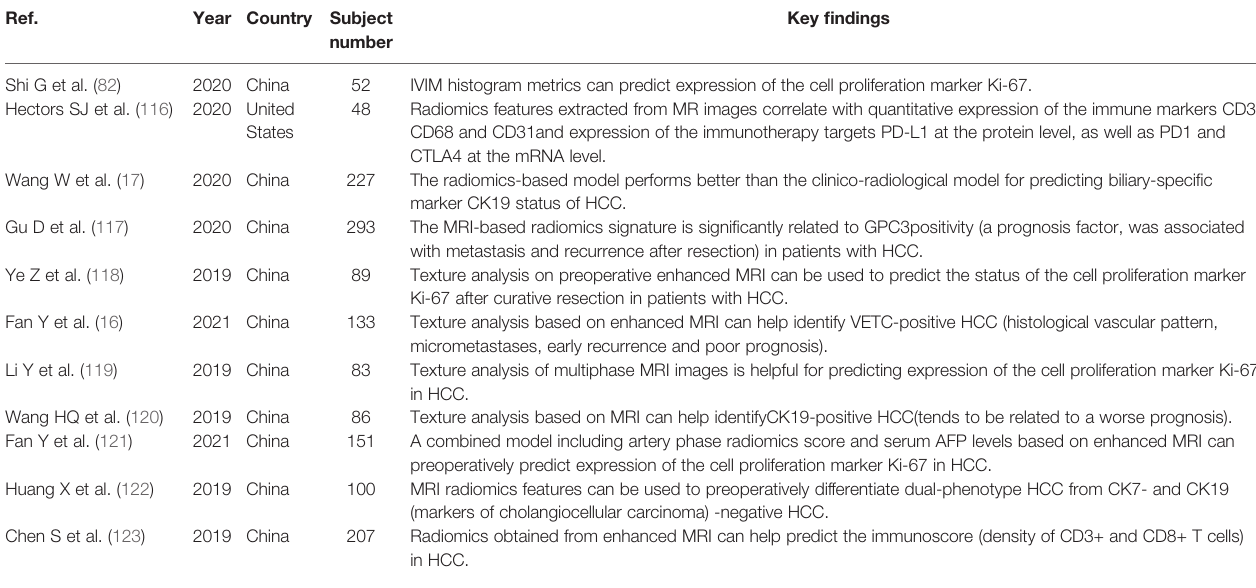
TABLE 1 | Summary of radiogenomics studies.